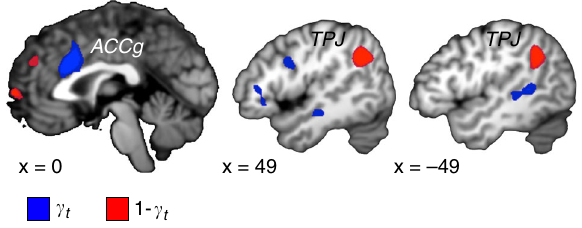
Fig. 4 Brain areas tracking the belief about the decision of another member in the group. Brain areas updating the belief about the decision of another member in the group when the outcome of interactions is revealed. Activity in the anterior cingulate gyrus (ACCg) correlated with model estimates of the belief γ t of participants about the extent to which one of the other members in the group free-rides in the current trial (blue). Activity in the bilateral temporoparietal junction (TPJ) correlated with model estimates of the belief (1 − γ t ) of participants about the extent to which one of the other members in the group contributes at the current trial, t (red). The statistical maps are thresholded with the same convention as Fig.